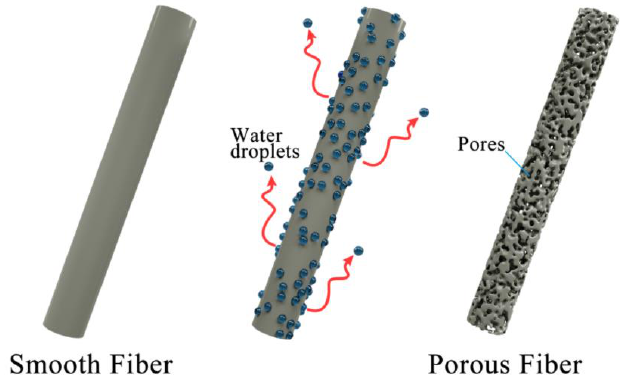
Figure 4. A schematic diagram of pores formed in fibers.